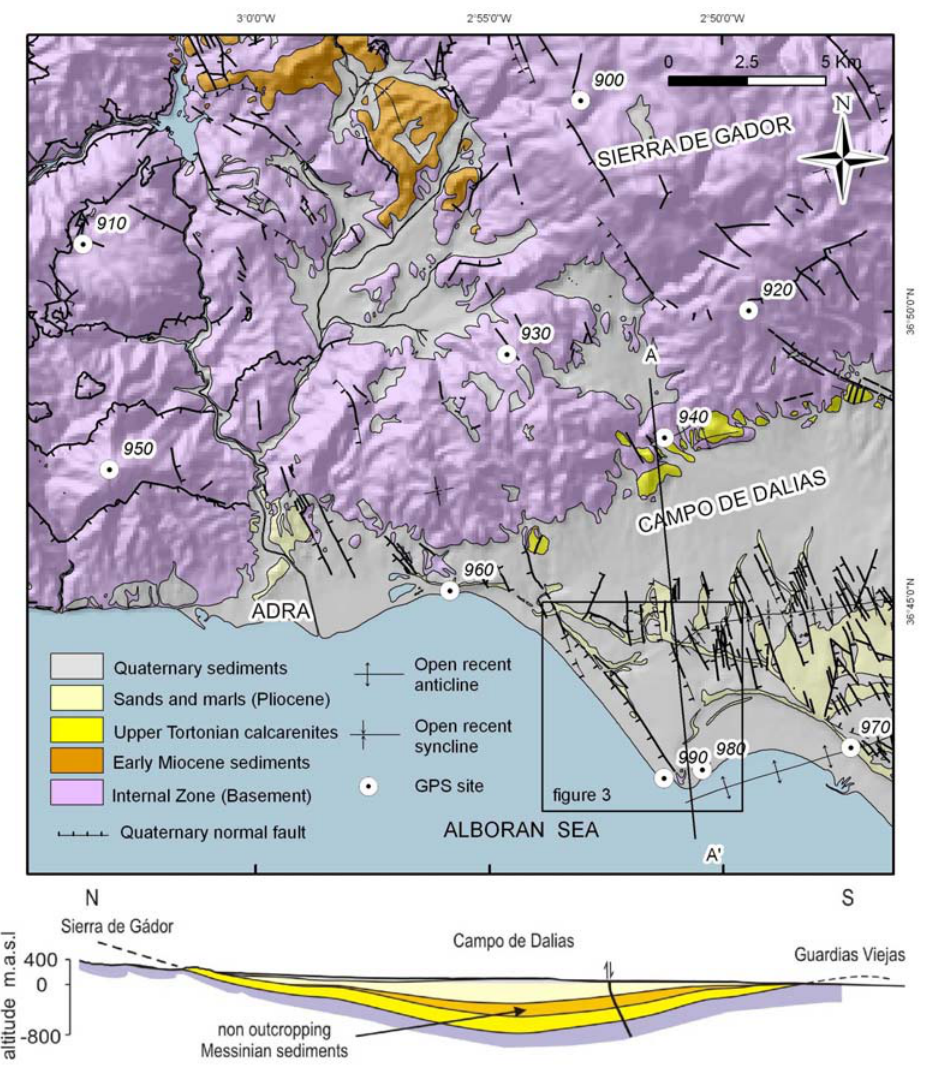
Figure 2. Geological map of the studied region. Location of GPS